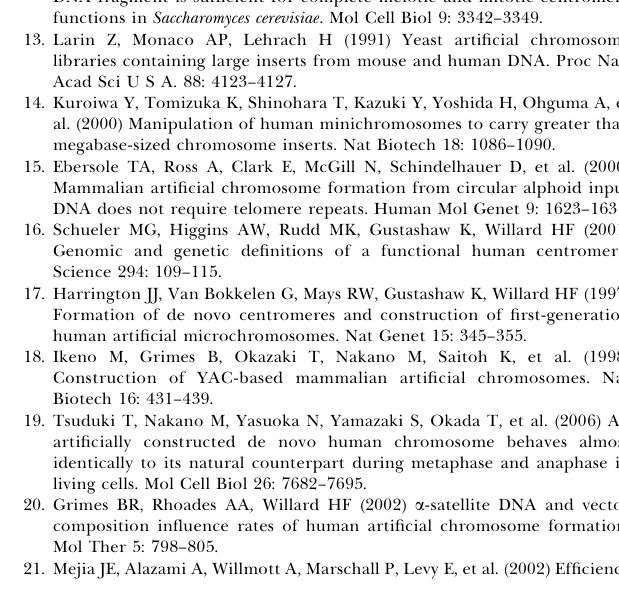
Figure S1. Metaphase Chromosome Spreads Labeled with FISH Probes Specific for the DsRed and nptII Gene Cassette (Green) or Centromere Sequences (Red) DNA is stained with DAPI (blue); autonomous MMCs (arrowheads). Size bar, 5 l